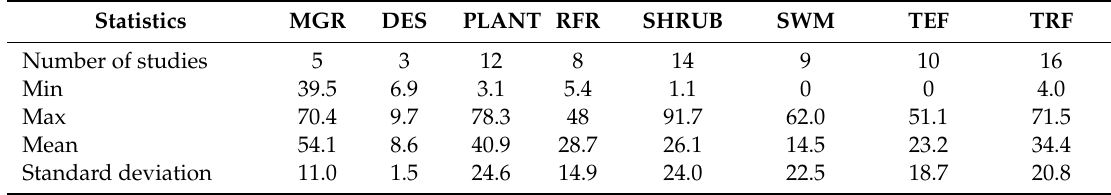
Table 6. Synopsis of the percentage (and dispersion measures) of venomous individuals within snake assemblages across habitats, on the basis of the selected studies. Statistics MGR